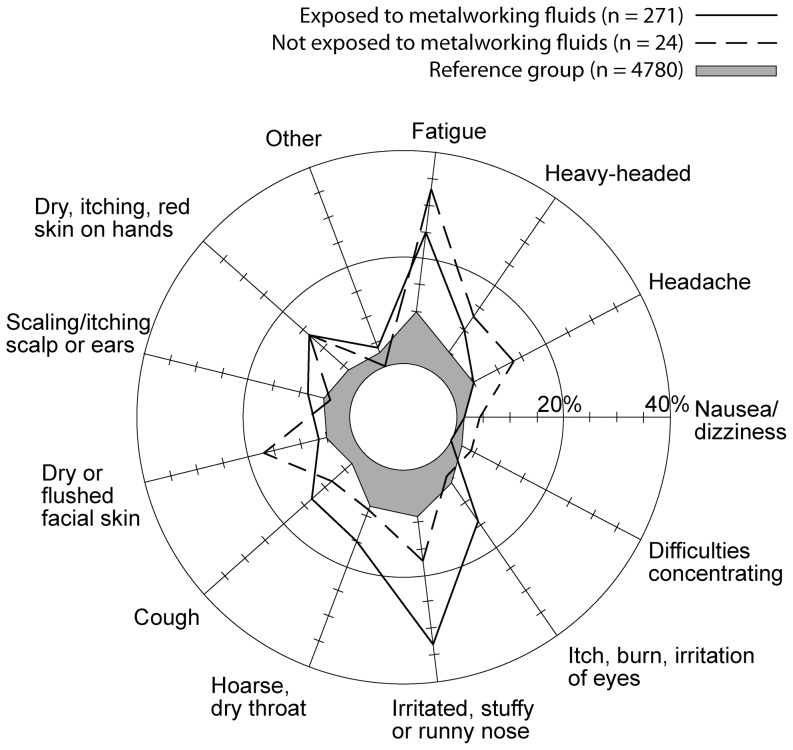
Symptoms reported by metalworkers exposed to metalworking fluid (271 individuals), metal workers not exposed to metalworking fluid (24 individuals) and non-exposed reference population (4780 individuals).The figure shows prevalence of experienced symptoms.